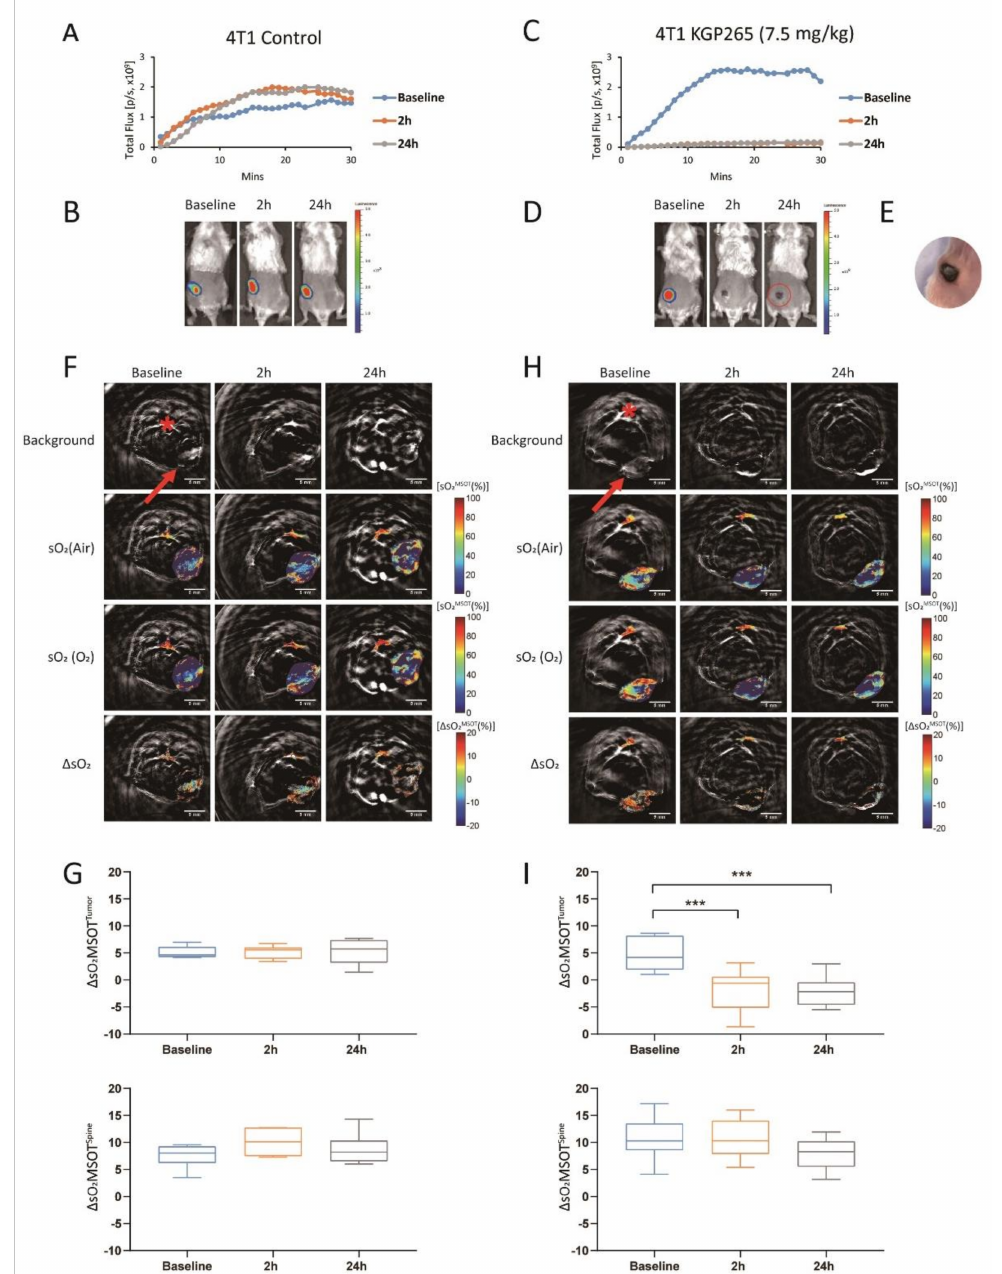
Figure 4. BLI and OE-MSOT of 4T1-luc mammary fat pad tumor response to KGP265. ( A , C ) BLI intensity curves for individual mice showing differential variations over a period of 30 min following the administration of luciferin at the baseline (blue), 2 h (orange) and 24 h (grey) following the administration of saline or KGP265 (7.5 mg/kg). ( B , D ) BLI signal intensity images overlaid as heat maps on gray-scale photographs of the BALB/c mice in ( A , C ), respectively, at about 20 min following the administration of luciferin at selected time points following the administration of saline or KGP265. All the intensity maps have same heat scale. ( E ) Expansion of the area indicated by the red circle in ( D ) indicating the region developing a black scar on the tumor surface over a period of 24 h following the administration of KGP265. ( F , H ) MSOT images showing cross-sections of 4T1 tumor-bearing mice with respect to saline or KGP265 (7.5 mg/kg): top single wavelength: 800-nm image showing anatomical details with parametric maps below. The spine ROI is indicated by the red star, and the tumor ROI is indicated by the red arrow. Spatial distribution of oxygen saturation when the mouse